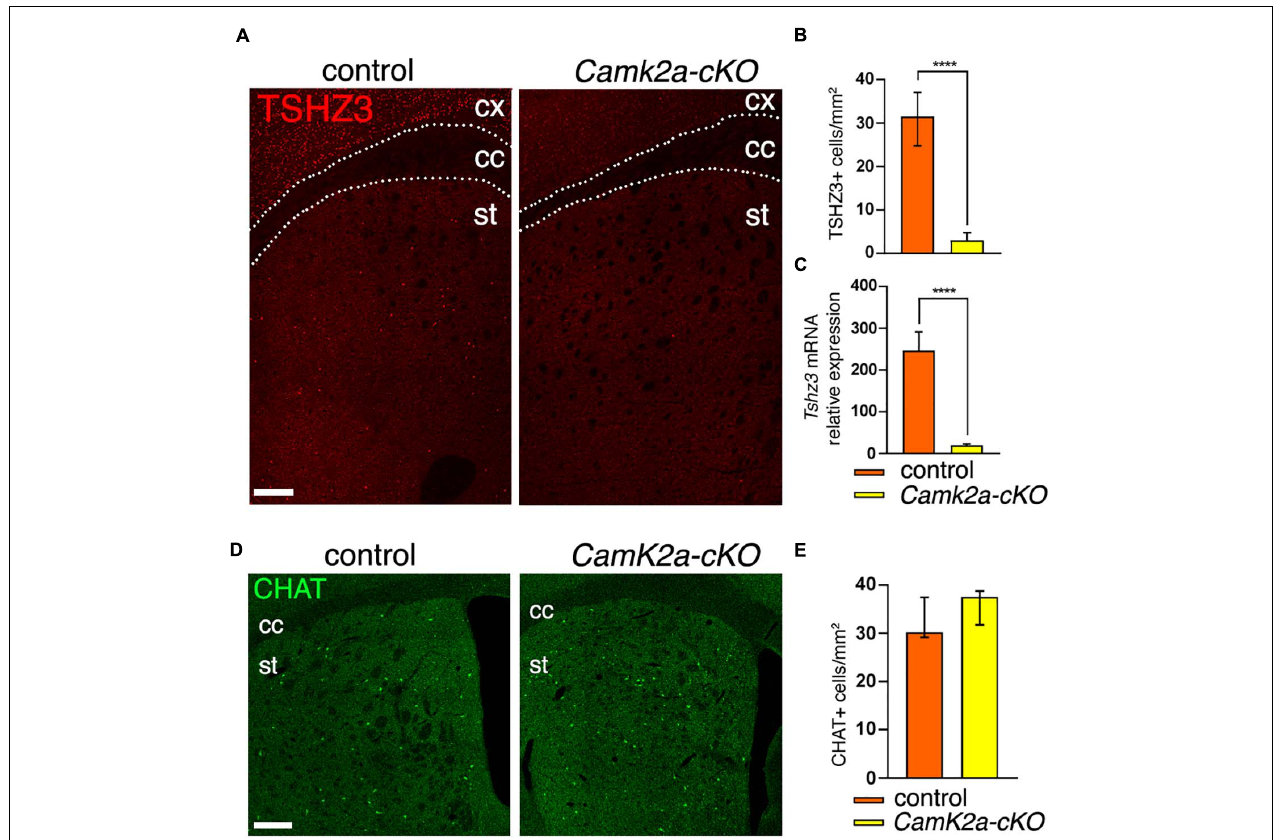
FIGURE 3 | Loss of Tshz3 in SCINs in Camk2a-cKO mice. (A) Coronal brain sections from control and Camk2a-cKO mice stained for TSHZ3. Scale bar, 500 µ m. (B) Densities of TSHZ3-positive cells in the striatum of control and Camk2a-cKO mice (898 cells in 28.1 mm 2 and 95 cells in 26.3 mm 2 for control and Camk2a-cKO , respectively, from three mice per genotype; **** P < 0.0001, Mann–Whitney test). (C) Tshz3 mRNA levels analyzed by RNA-seq in control and Camk2a-cKO striata (**** P adj < 1.00E-14, Log 2 FC = –2.26; data expressed as mean + SEM). (D) Coronal brain sections from control and Camk2a-cKO mice stained for CHAT. Scale bar, 300 µ m (E) Densities of CHAT-positive SCINs in control and Camk2a-cKO mice (758 cells in 23.6 mm 2 and 629 cells in 17.1 mm 2 for control and Camk2a-cKO , respectively, from three mice per genotype; P = 0.1014, Mann–Whitney test). Cell counts in B,E were performed on the whole striatal surface. Data in B,E are expressed as median with interquartile range. cc, corpus callosum; cx, cerebral cortex; st,